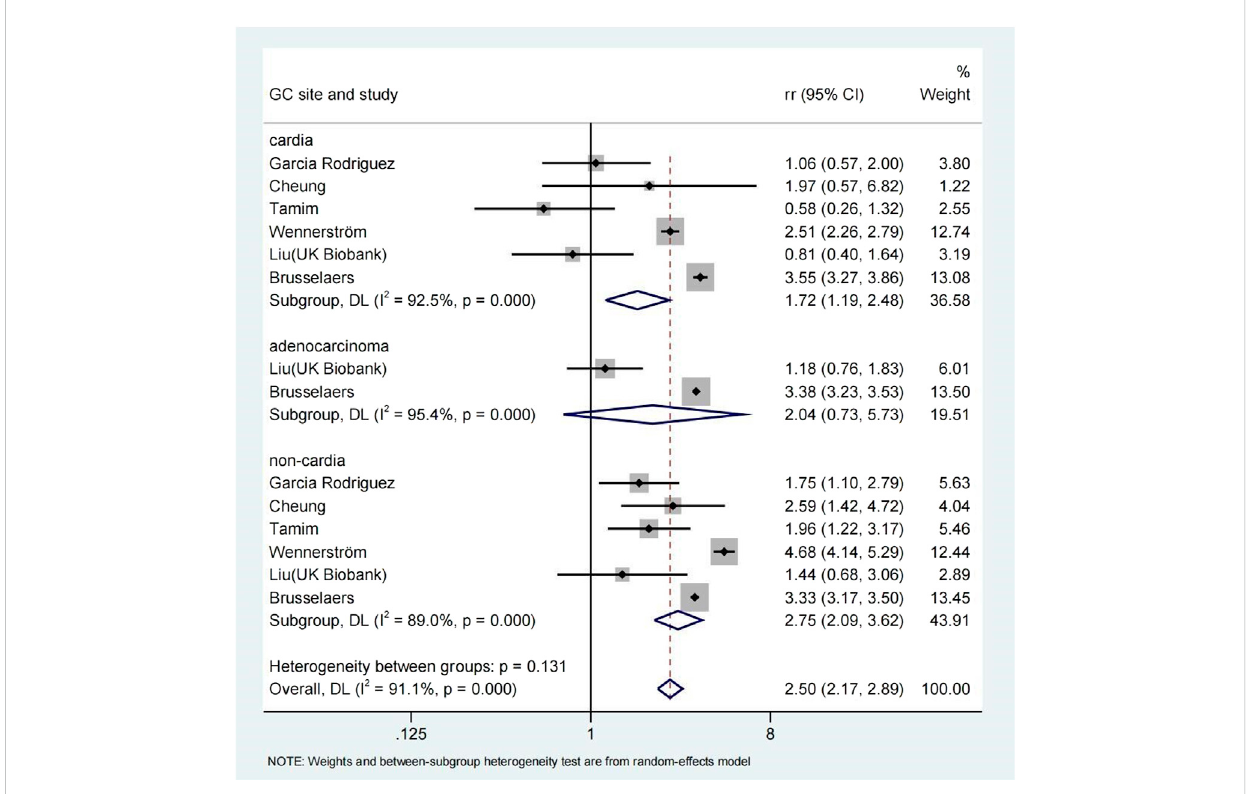
FIGURE 3 Association between the use of PPI and risks of Gastric Cancer strati fi ed by Gastric Cancer site.